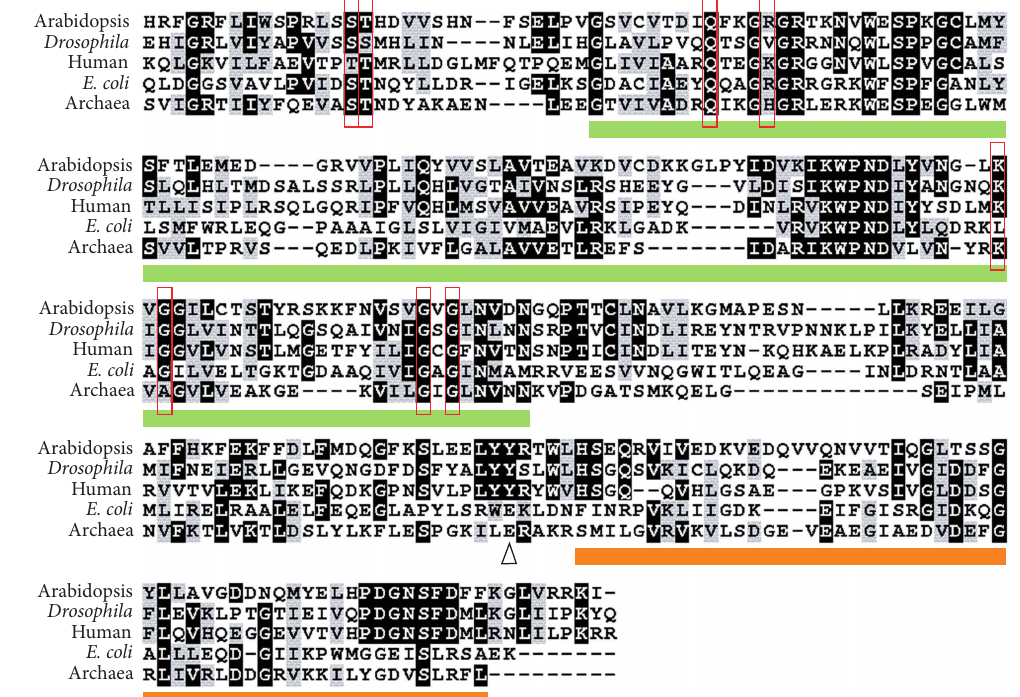
Figure 2: Multiple sequence alignments of HCS proteins. The highly conserved sequences of HCS proteins among different organisms were aligned using CLUSTALX [27]. Eight amino acids labeled by red boxes are required for biotin ligation according to the BirA crystal structure [22]. The BPL lipA/B and BPL C domains are underlined in green and orange, respectively. Δ is location of Y663 mutation in a patient with HCS deficiency.